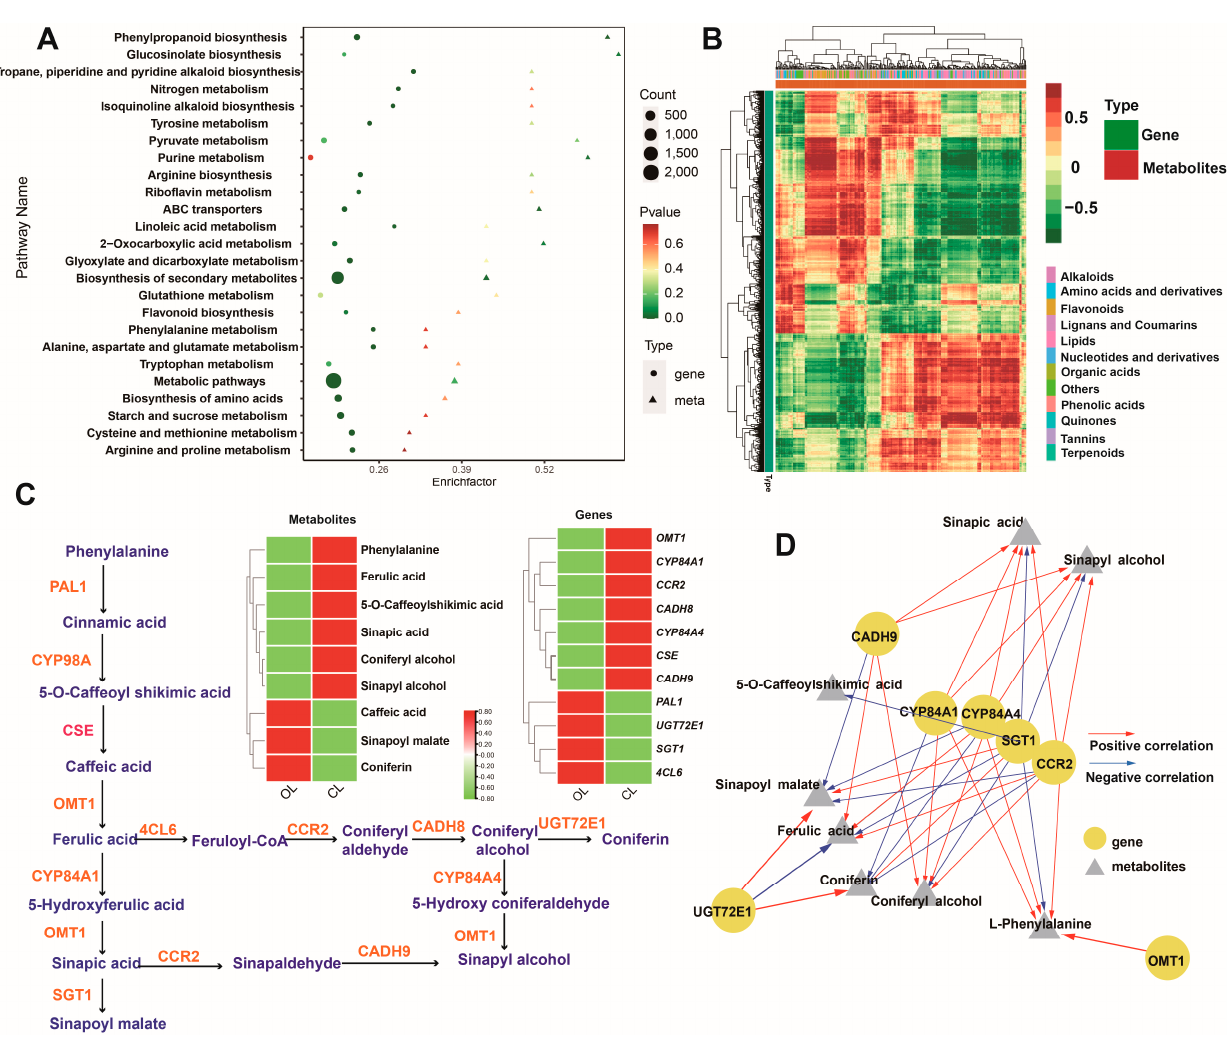
Figure 5. Conjoint analysis of the DEGs and DRMs: ( A ) KEGG pathways enrichment of the DRMs and DEGs; ( B ) clustering heatmap of the DEGs and DRMs; ( C ) DEGs and phenolic acids in the phenylpropanoid biosynthesis pathway; and ( D ) potential network between the genes and phenolic acids.